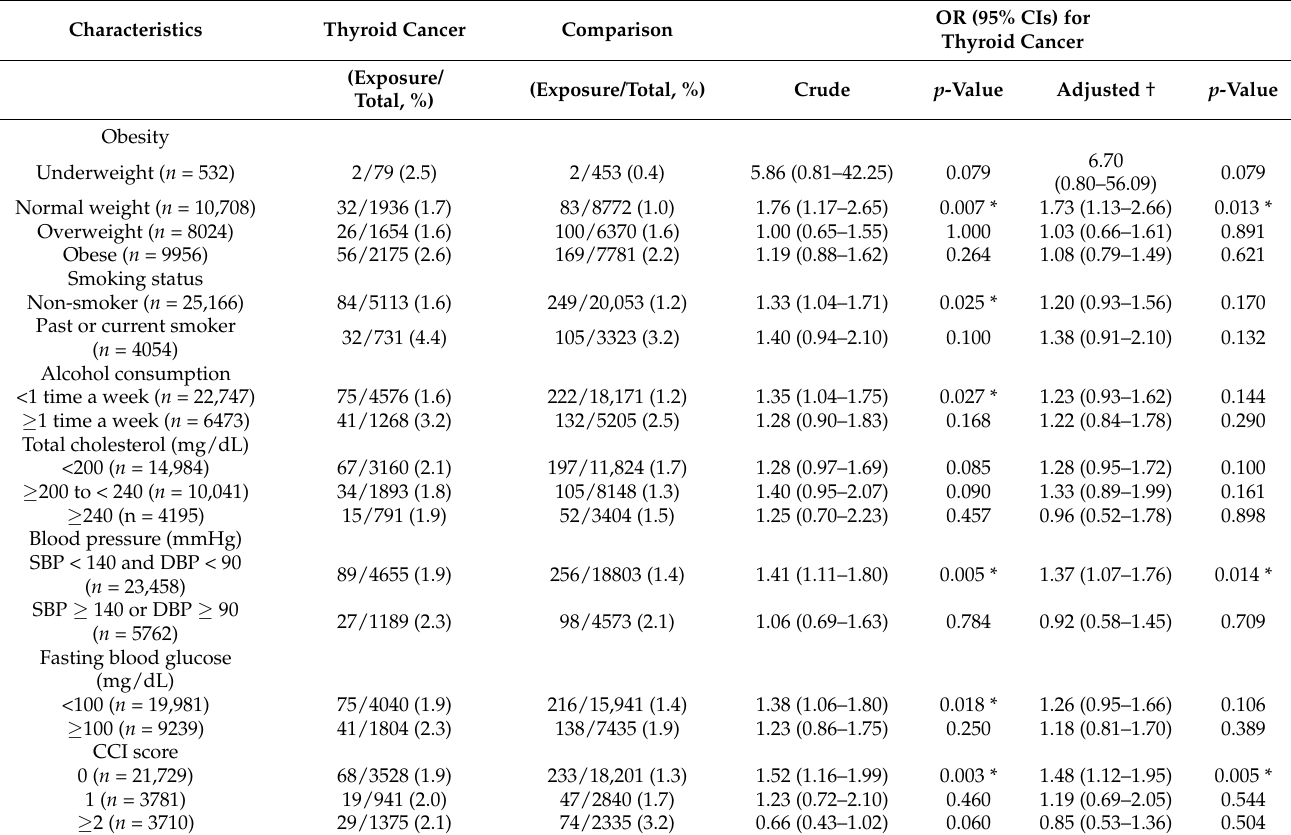
Table 3. Subgroup analyses regarding odds ratio (95% confidence interval) of gout for thyroid cancer with subgroup analyses according to obesity, smoking status, alcohol consumption, total cholesterol, blood pressure, fasting blood glucose, and CCI